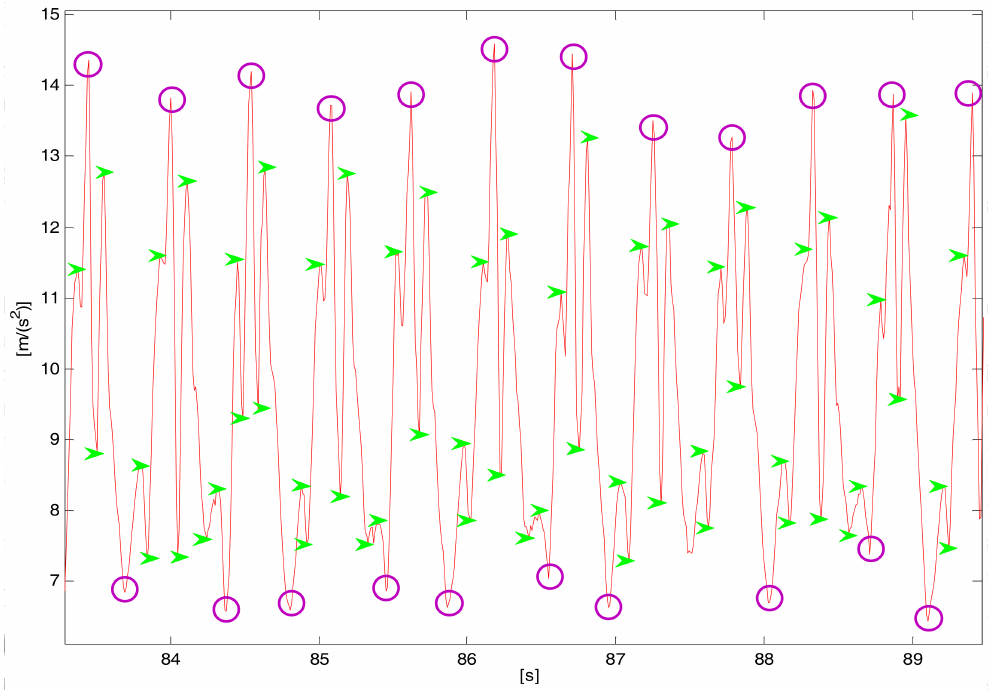
Figure 3. The change of vertical acceleration during